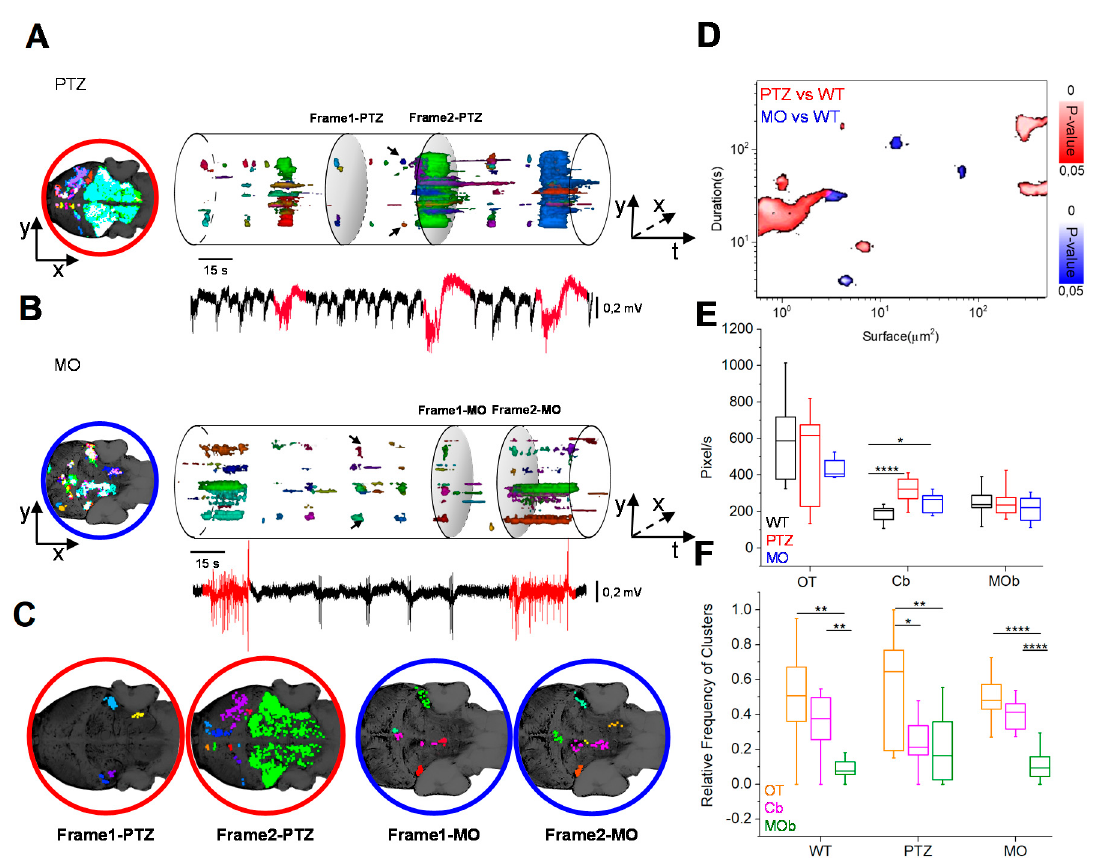
Figure 2 . Dynamic evolution of the Ca 2+ domains. ( A,B ) The volume representation depicts the active pixels from the binary stacks, clustered in domains of different colors of PTZ and MO larvae. The frame on the left is the projection of active domains during the entire period. The LFP events in red have high Ca 2+ recruitment (>700 voxels). ( C ) The shaded sections in A and B are the spatial patterns of activation during the interictal-like events (frame 1) and the generalized events (frame 2) in the PTZ (red) and MO (blue). ( D ) Difference of the spatio-temporal morphology of PTZ and MO clusters with respect to WT clusters. The maximum surface occupied by Ca 2+ clusters is plotted in relation to their duration. The color bars represent the p -value of the difference with the WT model. We report only the significative di ff erences ( p -value ≤ 0.05). 4 recordings for each larva, n = 3 larvae for each condition. ( E ) Comparison of the amounts of detected voxels for the three models in di ff erent anatomical regions. ( F ) Anatomical localization of the origin of the recruited neuronal clusters with volume > 300 voxels. The data have been normalized to the total number of active domains measured in each recording session (* p ≤ 0.05, ** p ≤ 0.01, *** p ≤ 0.001, **** p ≤